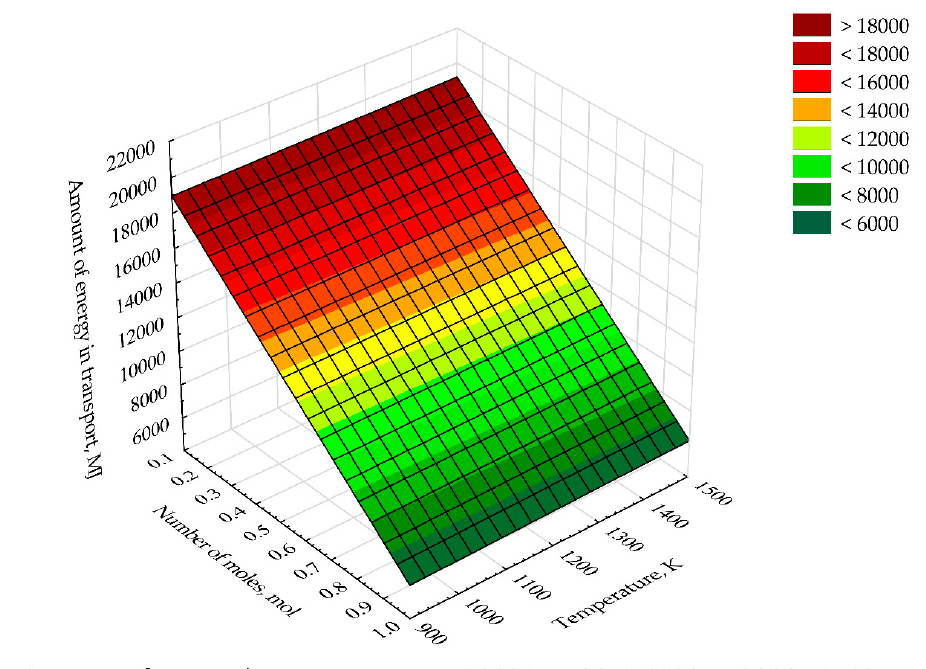
Figure 15. Energy content in the transport of syngas in the pressure vessels with a capacity of 14.960 m 3 at 200 bar at 293 K as a function of the number of moles of the gasification agent (x) and the temperature (y) of the gasification process using air.